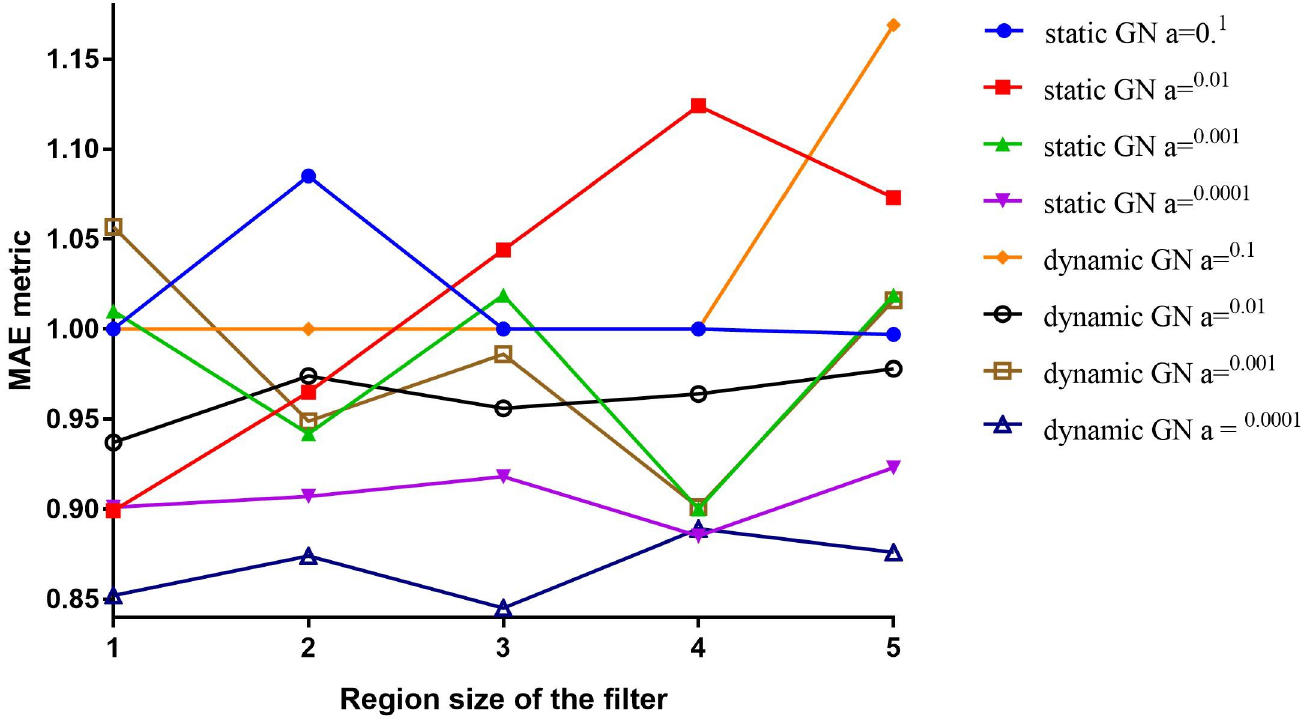
Fig 9. Effects of different learning rates and region sizes on the GN-based models.